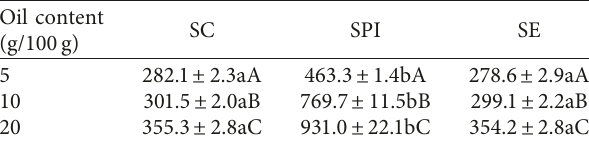
Different lowercase letters in each row indicate significant differences among samples of different emulsifiers, and different uppercase letters in each row indicate significant differences among samples of different oil contents ( p < 0 . 05).